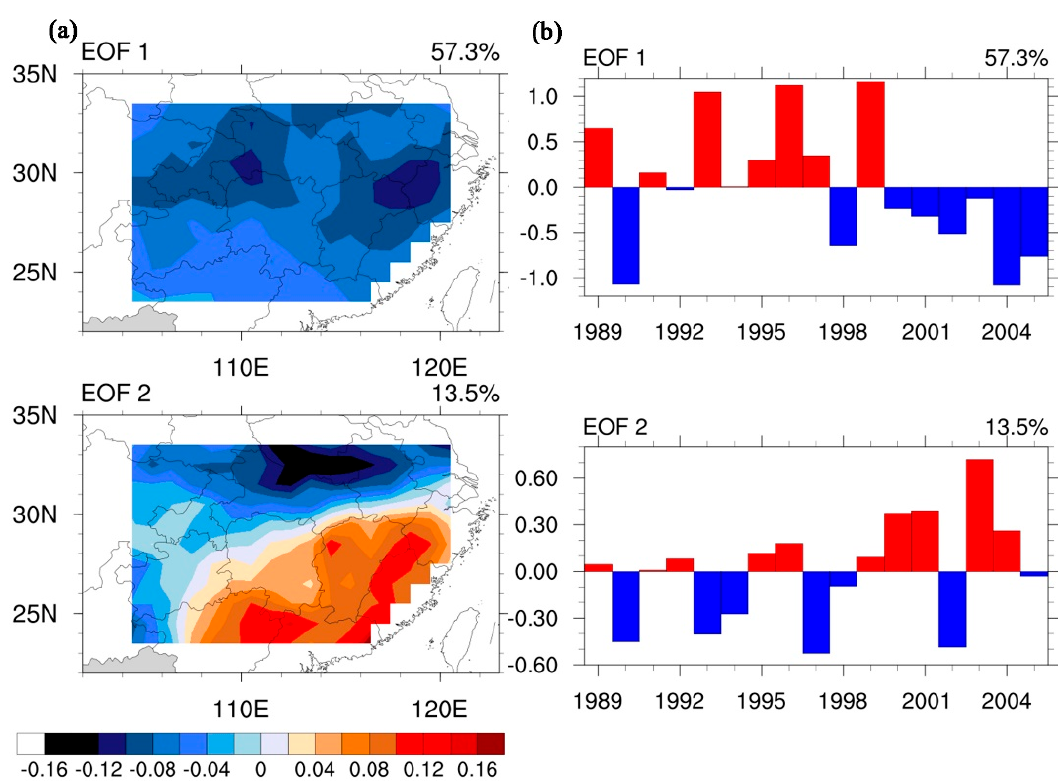
Figure 9. The spatial distribution ( a ) and principal components ( b ) of the first two modes in the energy-control region. The numbers in the upper right corner of the figure represent the explanatory variances in the first modes.